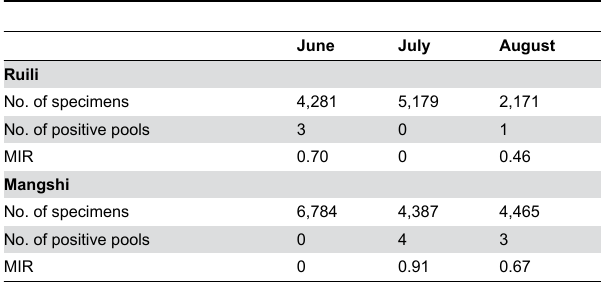
Table 7. MIR by month of JEV in Culex tritaeniorhynchus collected in Ruili and Mangshi, Jun-Aug, 2010.